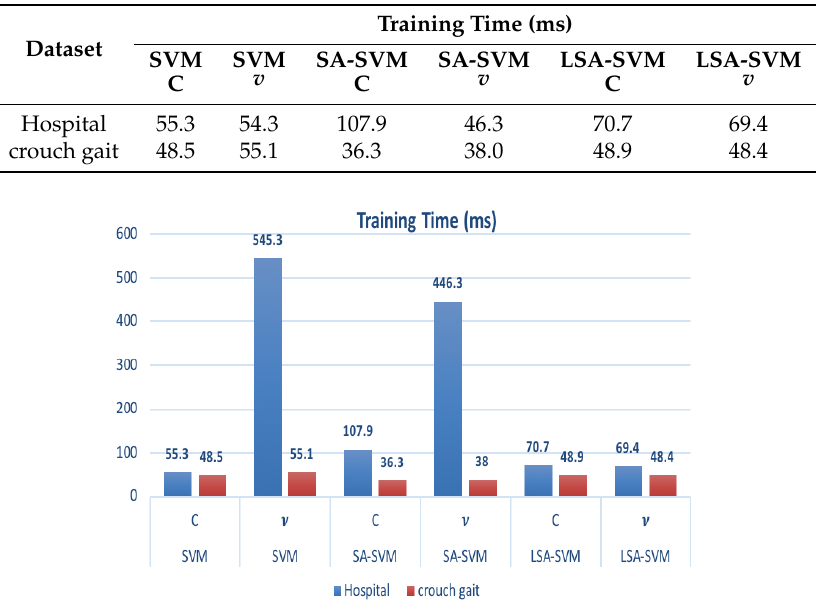
Figure 14. The training time consumption for each type of classifier.